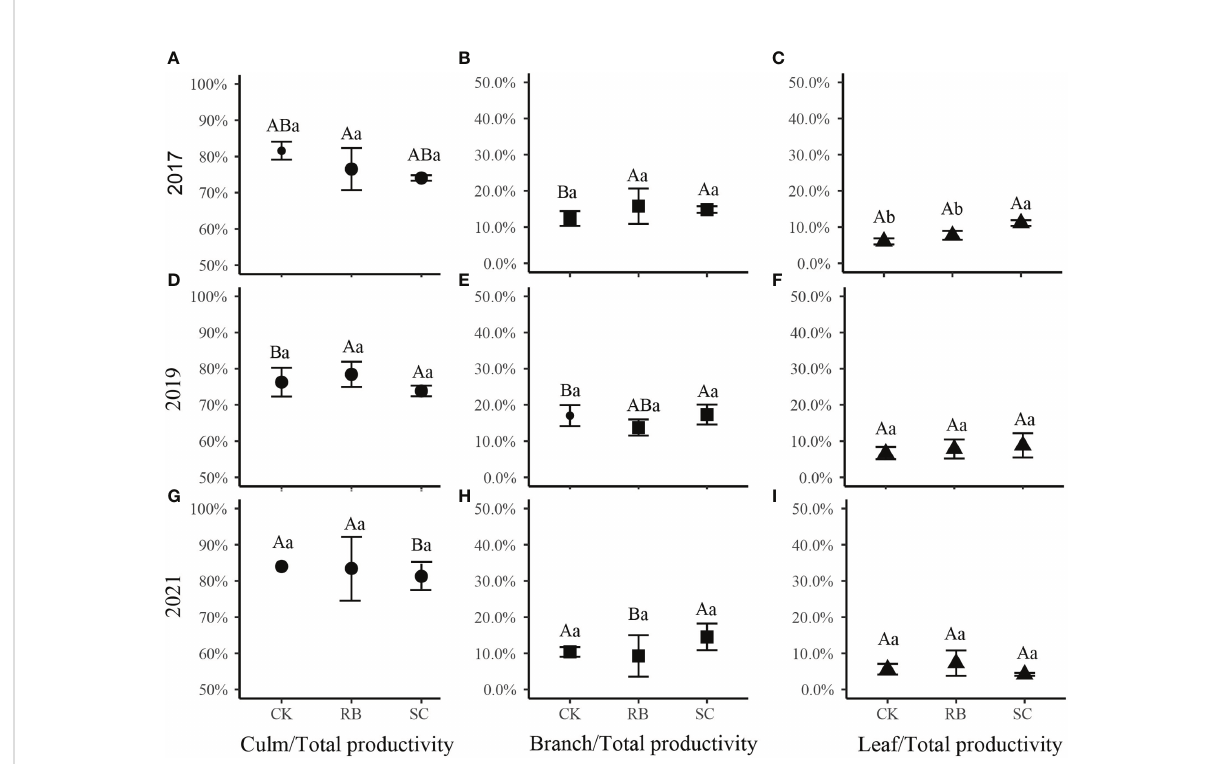
FIGURE 3 The ratio of each organ ( A, D, G , culm; B, E, H , branch; C, F, I , leaf) productivity to aboveground productivity of Moso bamboo in different treatment plots. Different lowercase letters indicate that there are signi fi cant differences in the ratio between different treatment plots at the same time (ANOVA and LSD test, p < 0.05); Different capital letters indicate that there are signi fi cant differences in the ratio at different times at the same treatment plots (ANOVA and LSD test, p < 0.05). Error bars indicate standard deviation (n = 3).